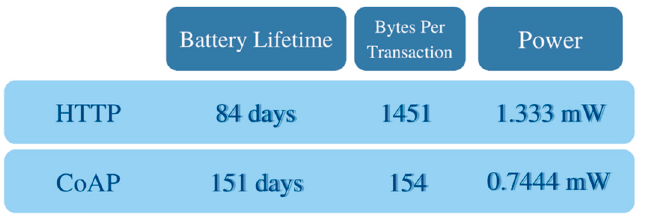
Figure 13. A performance comparison between CoAP and HTTP. CoAP consumes less power.